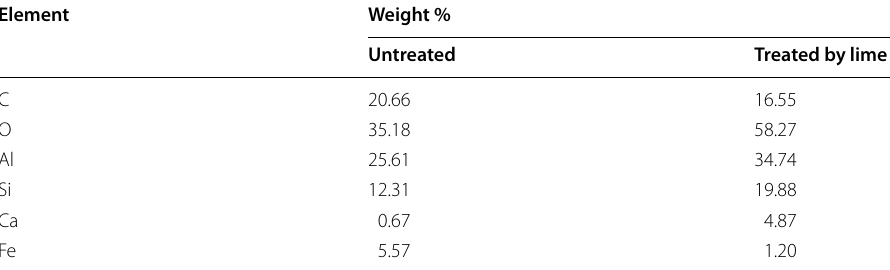
Table 11 Chemical composition of untreated and treated soil SR Element Weight